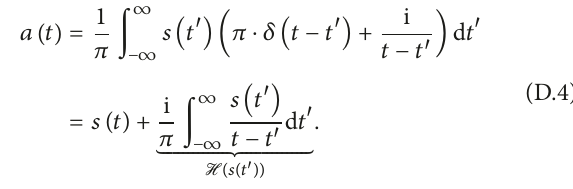
Figure 19: DFT with 2𝜋 periodic spectrum. The dimensionless frequency axis ranges from 0 to 2𝜋 whereas its resolution 𝜔 0 is determined by the length of the total data set 𝑇 = 𝑁 ⋅ 𝑇 s . It follows that the Nyquist frequency can be found at 𝜋 . In case that 𝑚 ≥ 𝑁 , whichisequalto 𝜔 ≥ 2𝜋/𝑇 s ,thespectrumrepeats.At 𝑚 = 0 ,theplot indicates the mean value of the analyzed data. An arbitrary higher frequency component is indicated at 𝑚 =